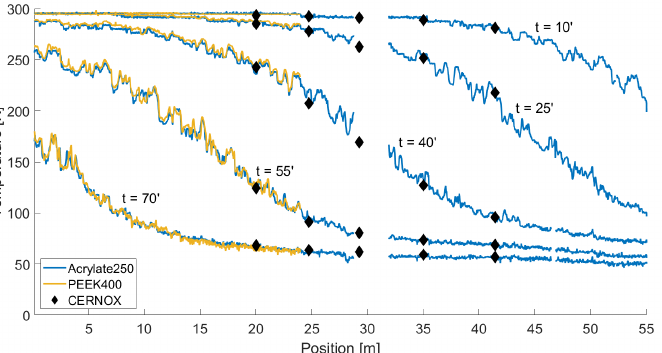
Figure 10. Temperature of the fibers along the whole SC link at different time